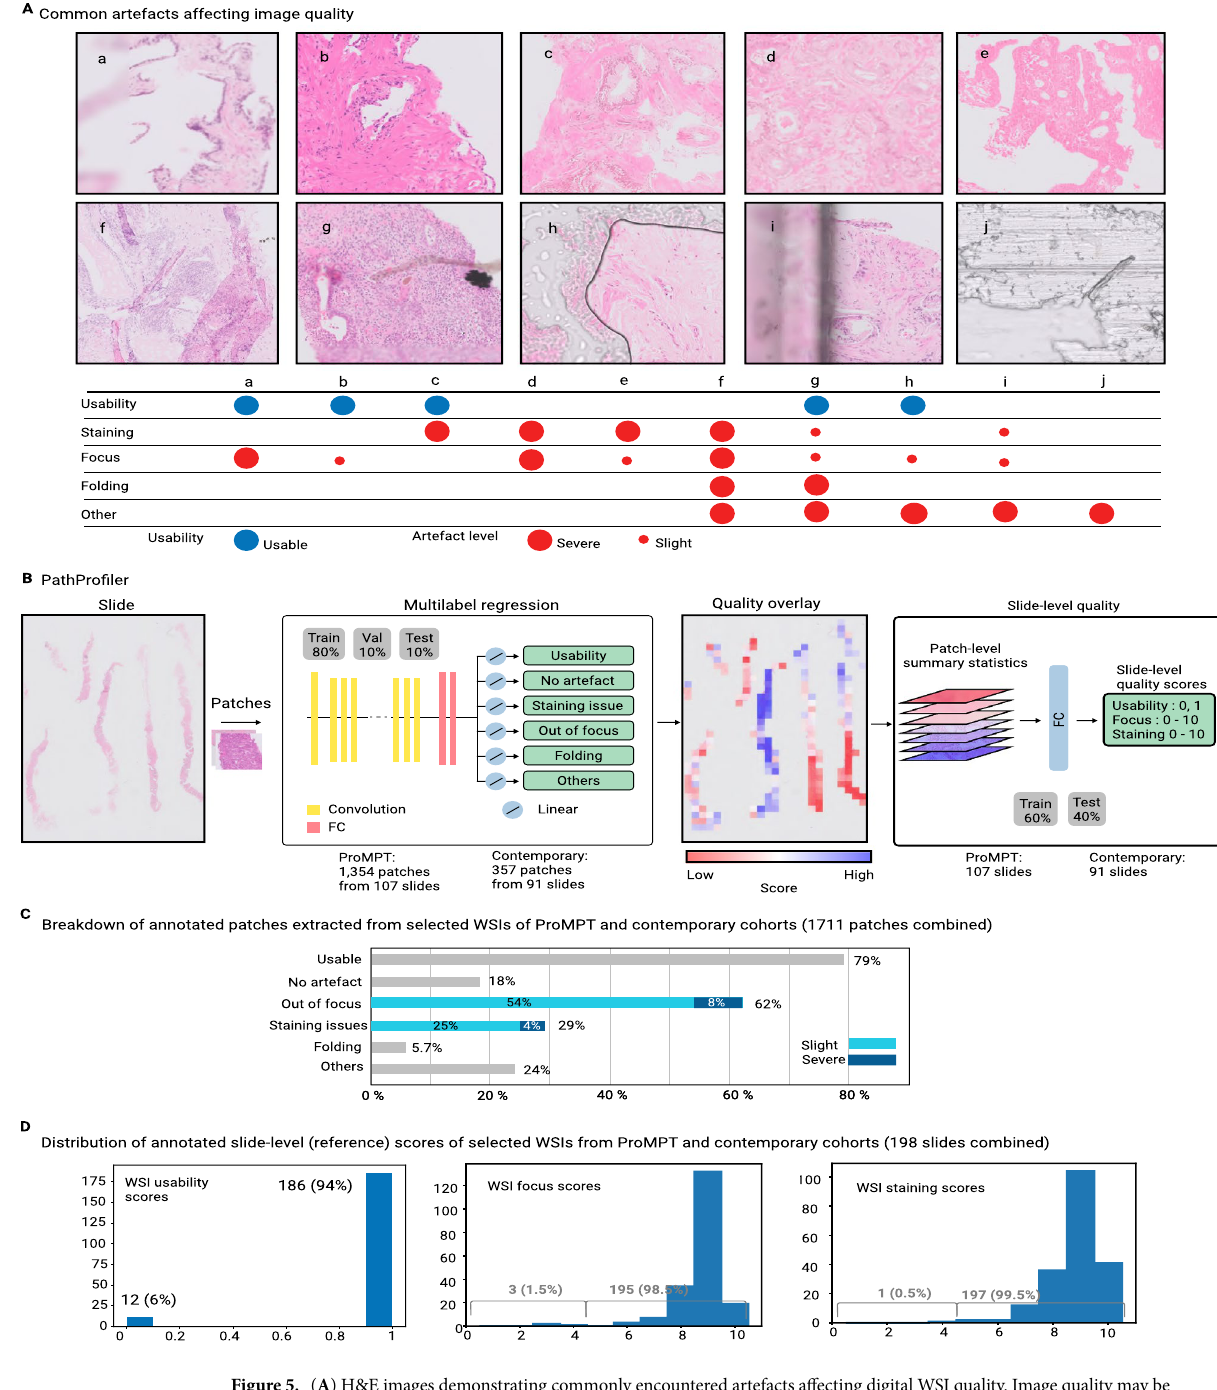
Figure 5. ( A ) H&E images demonstrating commonly encountered artefacts affecting digital WSI quality. Image quality may be affected by multiple artefacts, or just one, and focus quality can be specifically related to scanning/focus issues or it can be a result of other artefacts. (a, b) focus issue, (c) fading/loss of contrast of H&E stain, (d, e) both staining and focus issues (f, g) a combination of focus and staining issues with tissue folding and dirt, (h) bubble under the coverslip and slight focus issues in visible tissue area, (i) edge of the coverslip (affecting focus), (j) coverslip glue. ( B ) PathProfiler QA pipeline. After tissue segmentation, patches of 256 × 256 are extracted at 5 × magnification and resized to 224 × 224 to accommodate for the ResNet18 CNN model. For each patch, the trained model predicts the presence of an artefact, and for focus and H&E staining artefacts it also predicts a quality score for each patch, 0 = no quality issue, 0.5 = slight quality issue, 1.0 = severe quality issue. A quality overlay is generated for each output category. In the next step, we map the predicted quality overlays to the slide-level standardised scoring system. For this, statistical parameters of quality overlays are used to predict slide-level quality scores; overall usability of the WSI (binary 0 or 1), and a score 0–10 for quality of focus and H&E staining from the lowest quality to highest quality, where the cut-off score for acceptable quality for diagnostic purposes is 4. ( C ) The composition of the pathologist-annotated image patches extracted from selected WSIs of ProMPT and contemporary cohorts (combined) ( D ) The distribution of pathologist-annotated (reference) quality scores of WSIs selected from ProMPT and contemporary cohorts (combined) for WSI usability (binary 0 or 1), focus and H&E staining quality (0–10, as